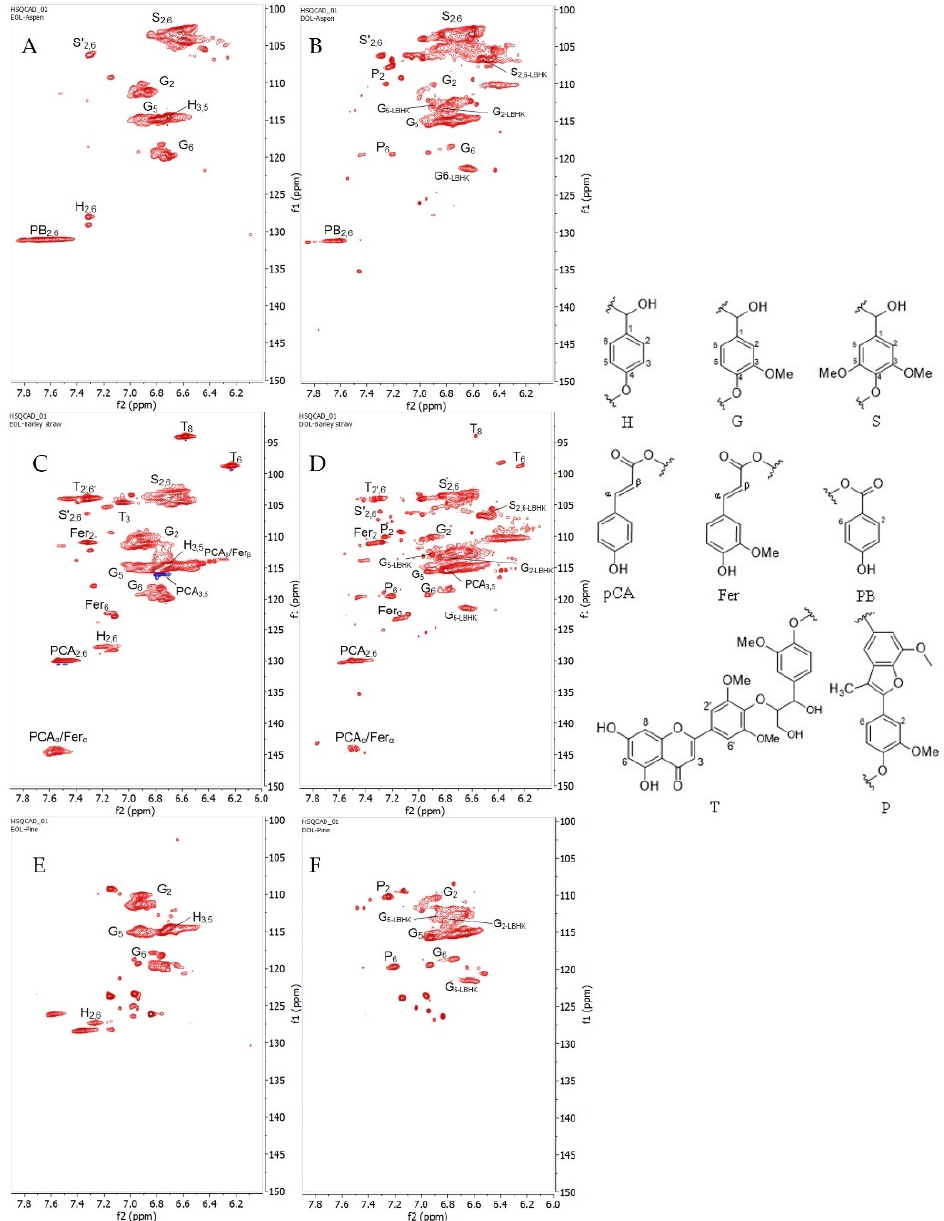
Figure 5. (Left) HSQC spectra that were presented in aromatic/unsaturated region from six organosolv lignins, ( A ) EOL-Aspen, ( B ) DOL-Aspen, ( C ) EOL-Barley straw, ( D ) DOL-Barley straw, ( E ) EOL-Pine, and ( F ) DOL-Pine. Red cross peaks are CH 3 and CH. (Right) ( H ) p -hydroxyphenyl unit; ( G ) guaiacyl unit; ( S ) syringyl unit; ( pCA ) p -coumarates; ( Fer ) ferulates; ( PB ) p -benzoate; ( T ) tricin; ( P ) methyl-substituted